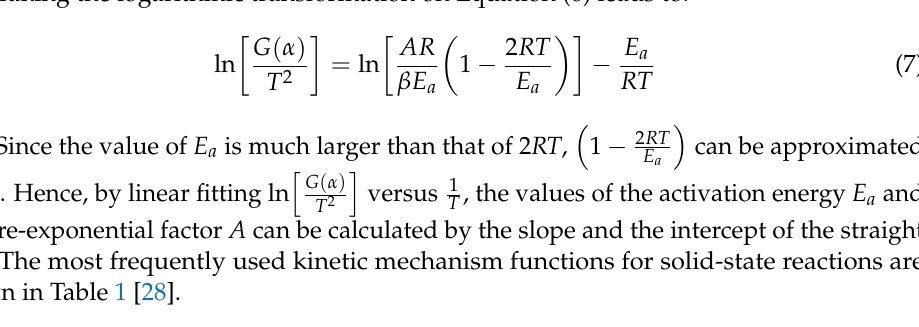
Table 1. The most widely used kinetic mechanism functions for solid-state reactions [28]. Mechanism Model